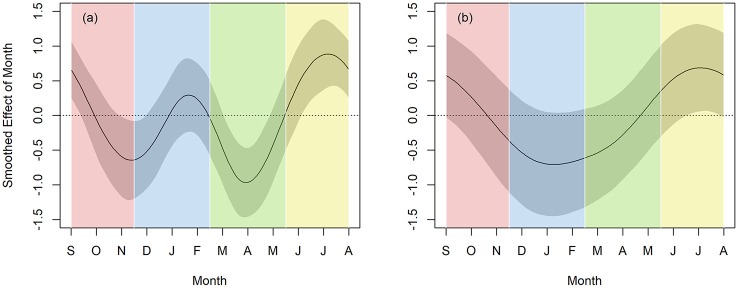
Left. Amount of touchscreen activity by season for females of breeding age (> 3 years). Right. Amount of touchscreen activity by season for females of non-breeding age (< 3 years). Black lines represent means, grey areas represent 95% confidence intervals. When the grey line does not overlap with the central y = 0 line, the amount of touchscreen activity is significantly different from chance. The x axis is scaled in months, beginning in September and ending in August. The colored vertical bands represent the different seasons.